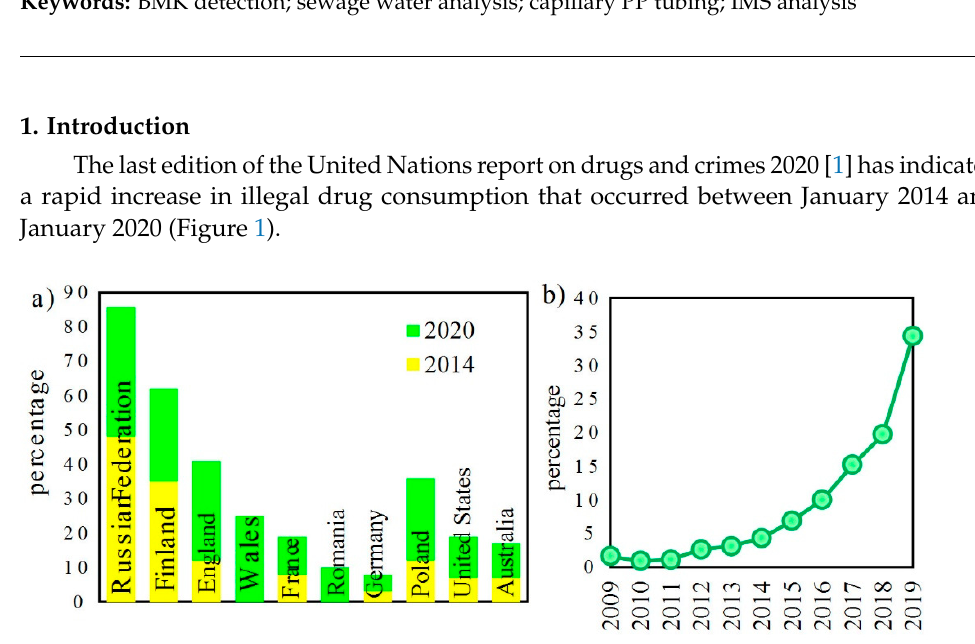
Figure 1. ( a ) Percentage of people in selected countries who use and buy drugs via the darknet in 2014 and 2020; ( b ) percentage of people buying drugs via the darknet for the first time [1]. It can be expected that the situation later in 2020 might be even worse due to the pan- demic crisis. Therefore, there is a strong need to localize illegal drug producers. Waste